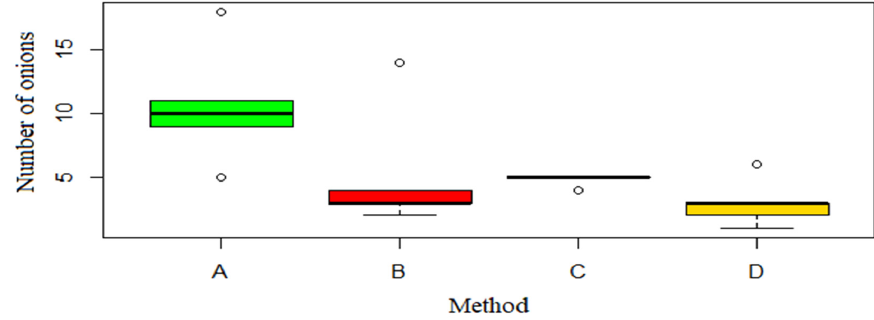
Figure 11. The number of onions harvested from plots that are not a productive yield.